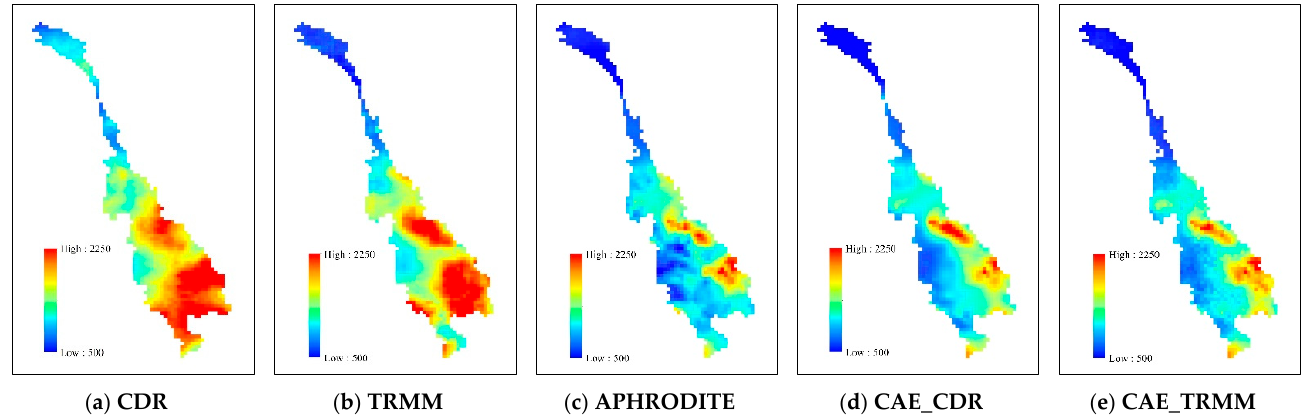
Figure 5. Spatial rainfall distribution of products over the MRB in 2014.